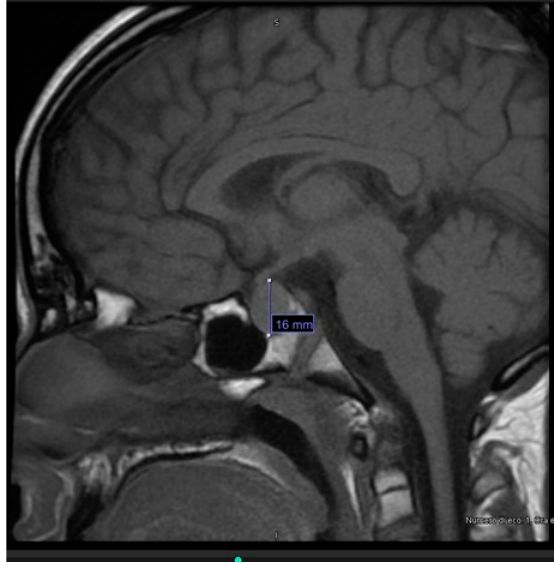
Figure 3. MRI of pituitary hyperplasia. The pituitary function evaluation disclosed hyperprolactinemia (PRL 118.4 ng/mL,